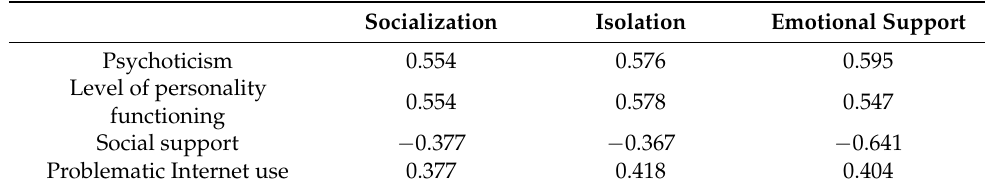
Table 2. Latent correlations among the three HQ-25 factors and variables of